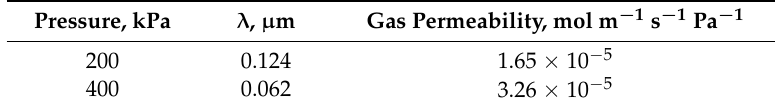
Table 2. Calculated tritium permeability through the pores of the MGLC at 400 ◦